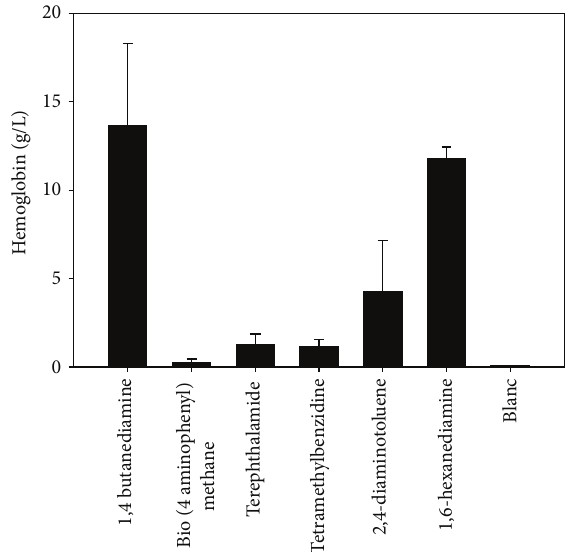
Figure 2: Hemolysis of washed human erythrocytes during 4-hour direct contact with commonly used polymer